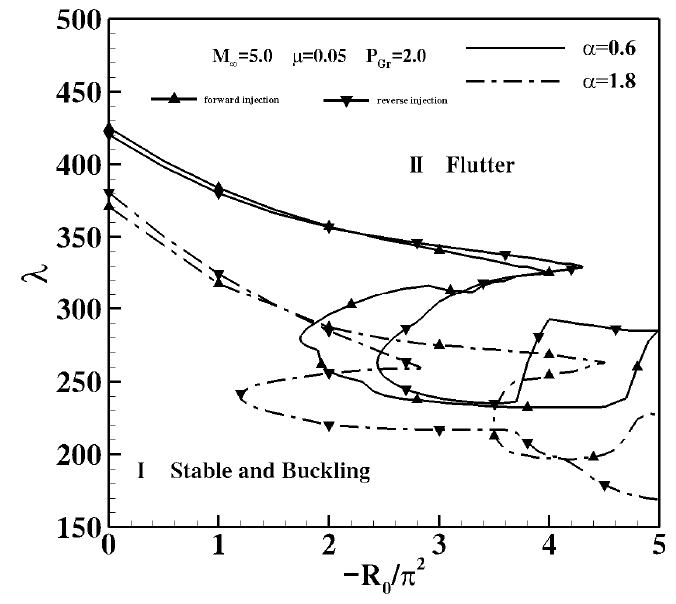
Figure 15. Stability regions under different injection directions.